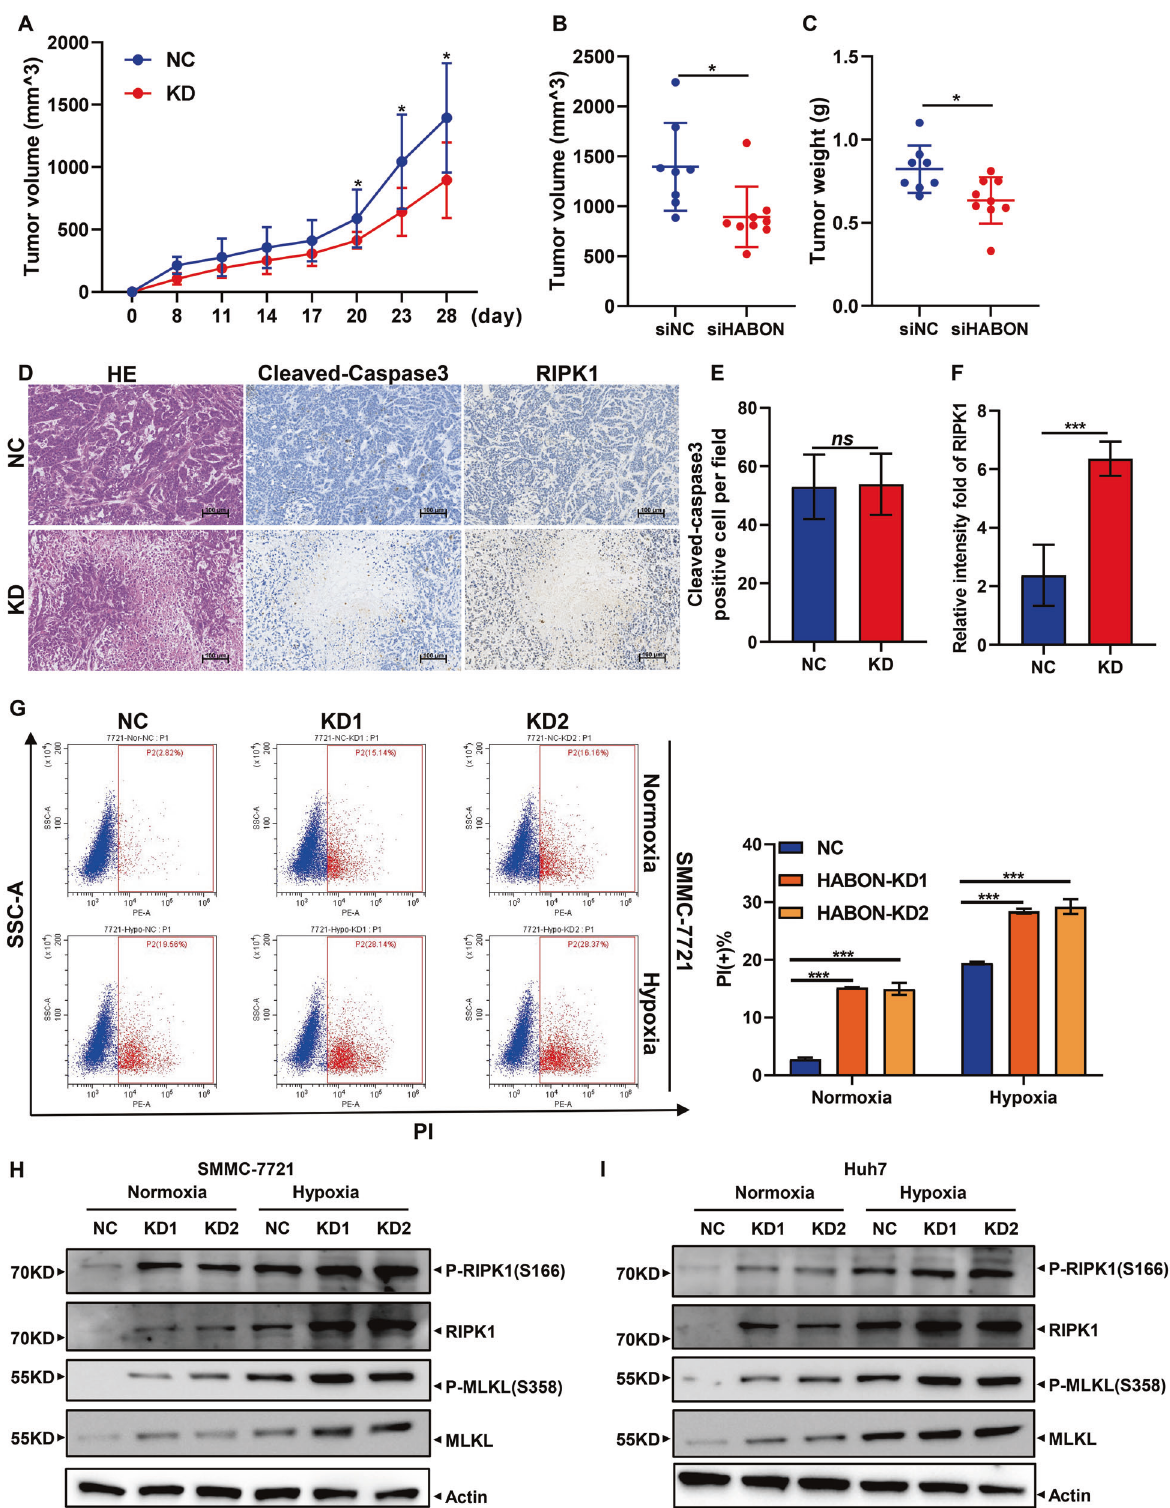
above analysis, it is suggested that the proteins enriched by HABON are mainly involved in the regulation of mitochondrial function, we fi rstly analyzed the intracellular localization of HABON. We